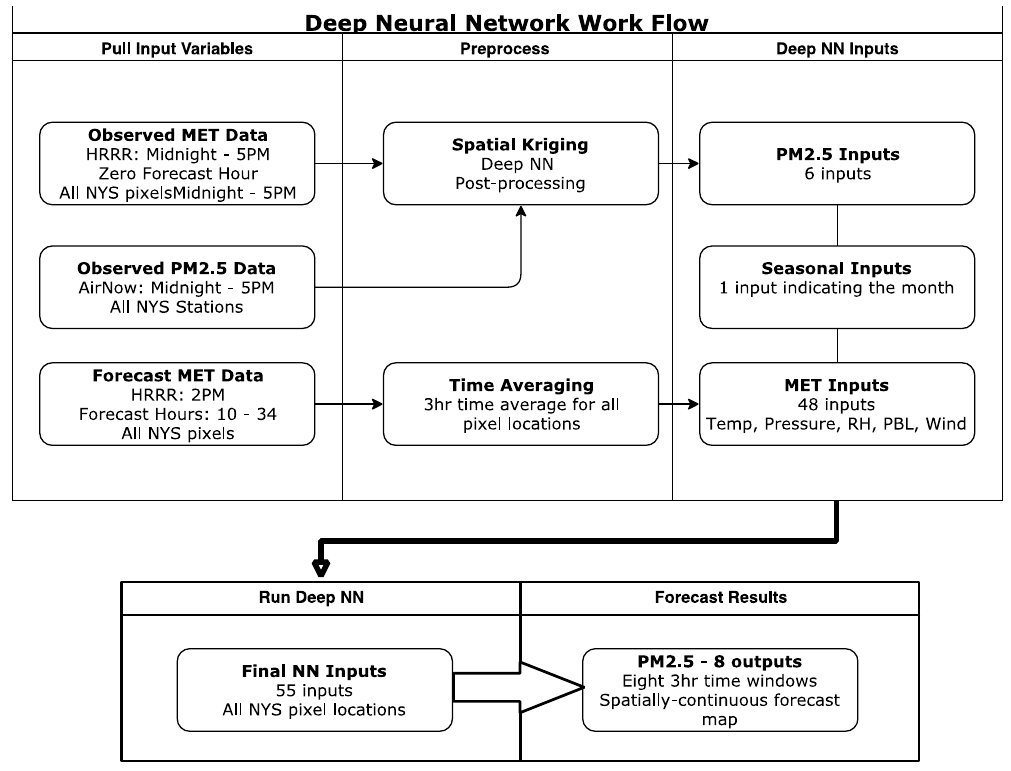
Atmosphere 2021 , 12 , x FOR PEER REVIEW Figure 7. Workflow of the DNN operational forecaster. Figure 7. Workflow of the DNN operational forecaster.